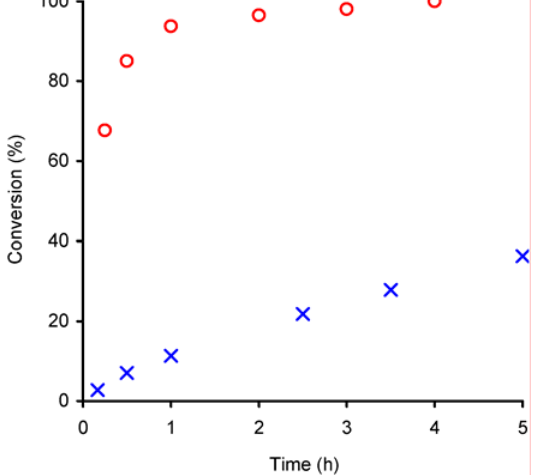
Figure 3. Kinetics of the epoxidation of cyclooctene with t -BuOOH in decane at 55 ºC, catalysed by compounds 1 ( ○ ) and 2 ( ×